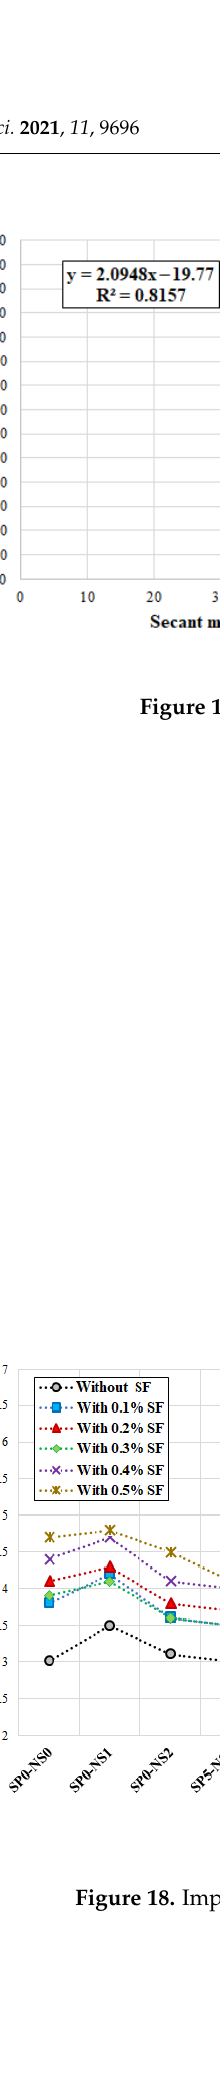
( b ) Figure 19. Effect of the fibres on the porosity of HSC containing NS and SP ( a ) SF and ( b ) PPF. Figure 19 shows the impact of a combination of NS, SP, SF and PPF on the porosity of HSC. SF increased the water absorption of SF reinforced HSC, and further using 10% SP considerably it. Conversely, using 5% SP decreases the value of this property, whereas using 1% NS substantially enhanced it when less than 5% SP was employed. Besides, us- ing 1% NA led to reducing the water absorption when using 10% SP and using 2% NS and 10% SP with 0.5% SF has a far-reaching influence on raising the water absorption. Therefore, a combination of 0.5% SF and 10% SP with 0% and 2% NS increased this prop- erty by nearly 103% and 115%, respectively. The same trend was experienced when PPF was used; however, the impact of PPF on water absorption was greater than that of SF. Consequently, using 0.5% PPF and 10% SP together with 0% and 2% NS raised this prop- erty by 147% and 173%, respectively (Figure 19b).